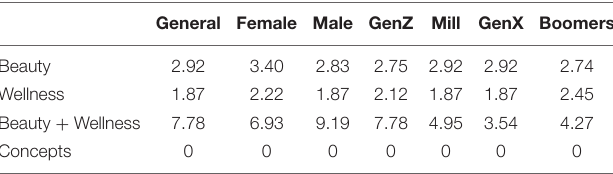
TABLE 5 | Standard deviations (SD) of the distribution of the different category words into the identified communities in the different semantic